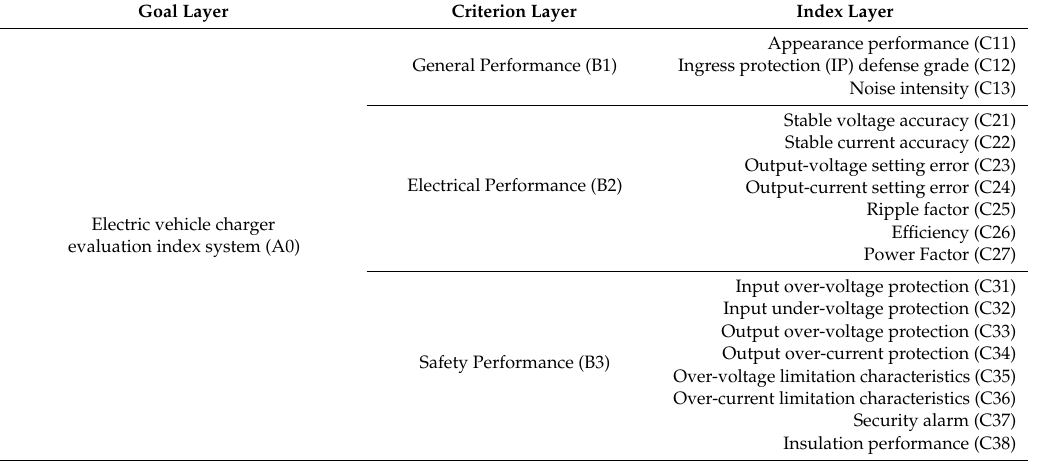
Table 1. Performance status evaluation index system of electric vehicle (EV) charging